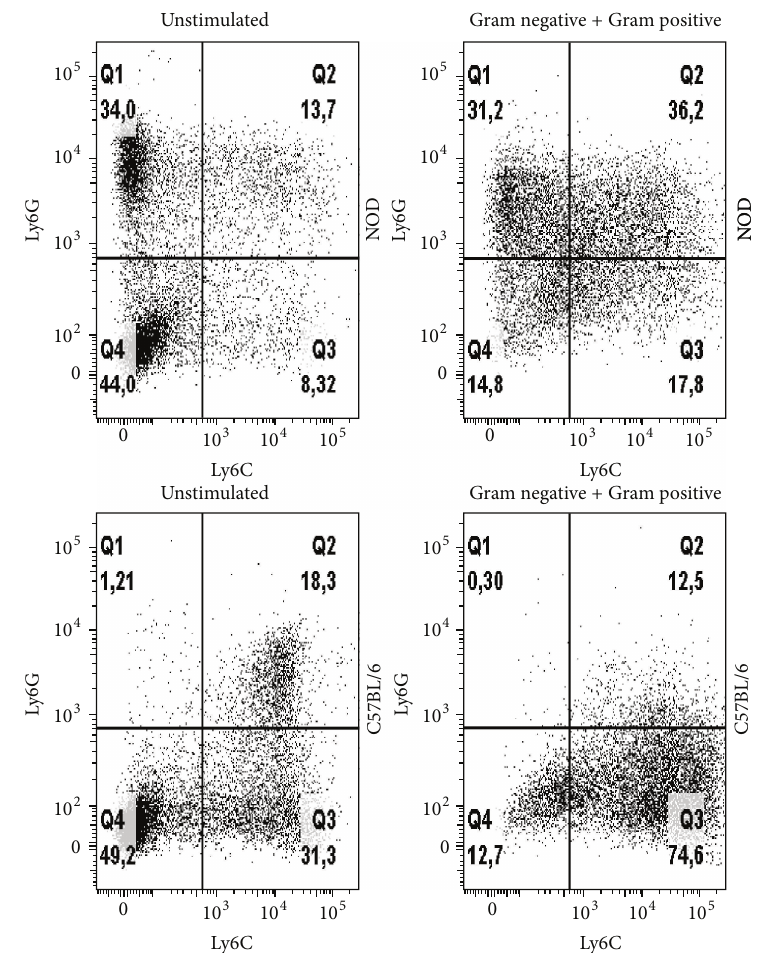
Figure 6: Bacterial stimulation of cultured bone marrow cells from NOD and C57BL/6 mice. On day 3 of in vitro culturing of bone marrow cells from NOD and C57BL/6 mice, mix of cells was stimulated as Gram-positive and Gram-negative bacteria (each MOI 0,5). On day 6 the cultured cells were harvested and analysed by flow cytometry. All CD11b + cells were defined positive or negative for Ly6C and Ly6G. Plots are representative for 1 of 4